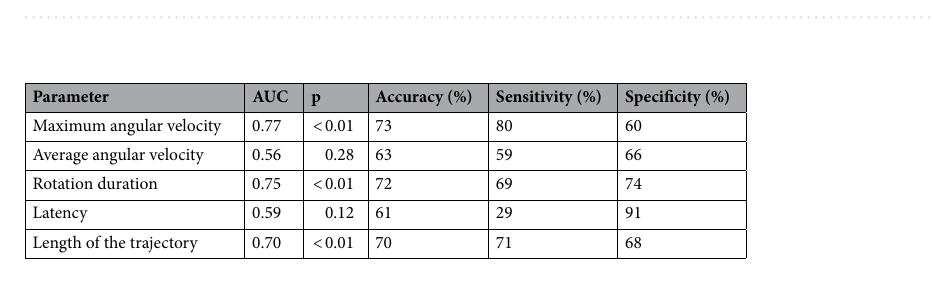
Table 1. Comparison of healthy persons and unhealthy patients according to selected parameters.